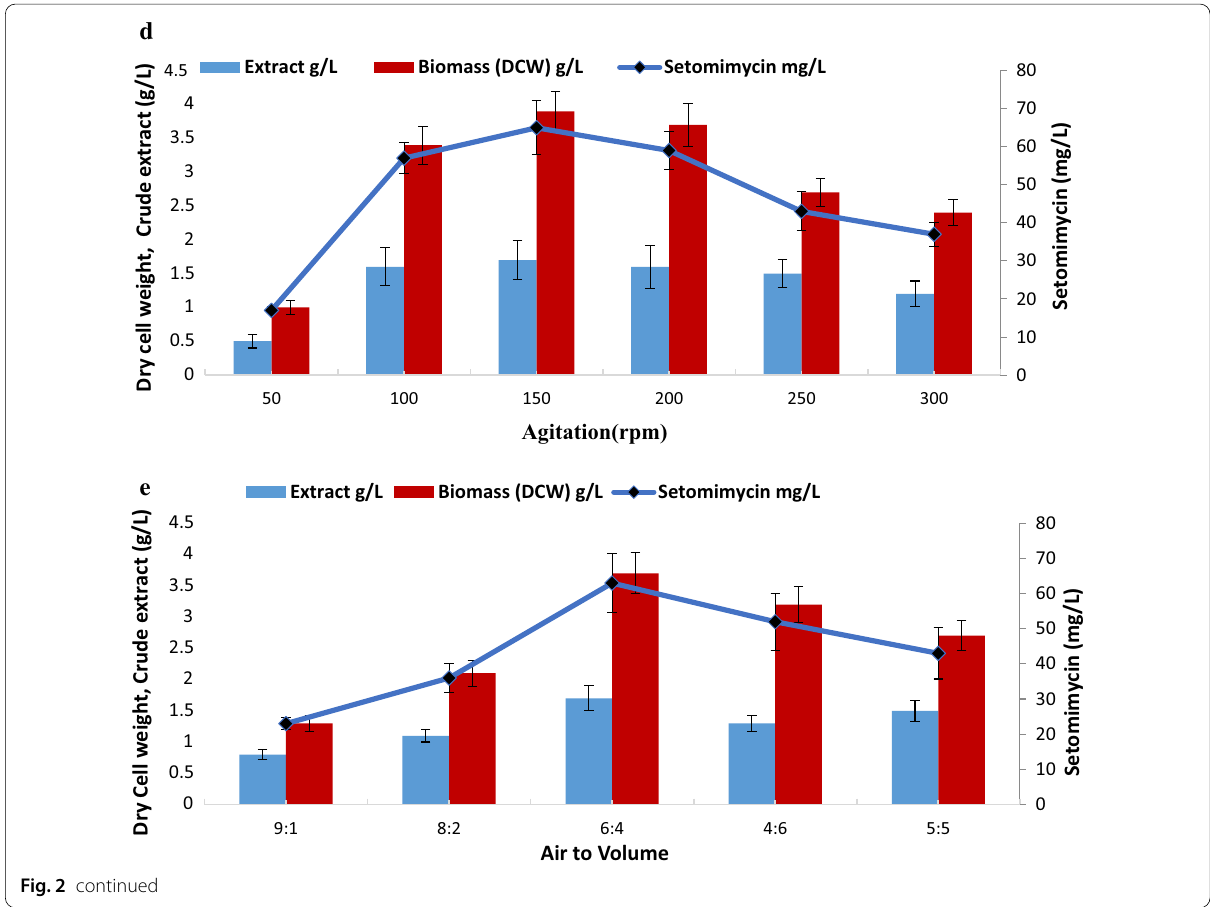
illustrated in Additional file 1: Table S3. For each experi- ment, the responses in terms of biomass (DCW g/L) and setomimycin content (mg/L) were evaluated. The mean responses for each run in the array were analyzed in terms of Signal- to- noise (S N) ratio to study the varia- = tion. Analysis of the graphs and ANOVA was carried out using Minitab (version 20) in terms of S/N ratio as larger the best using following equation